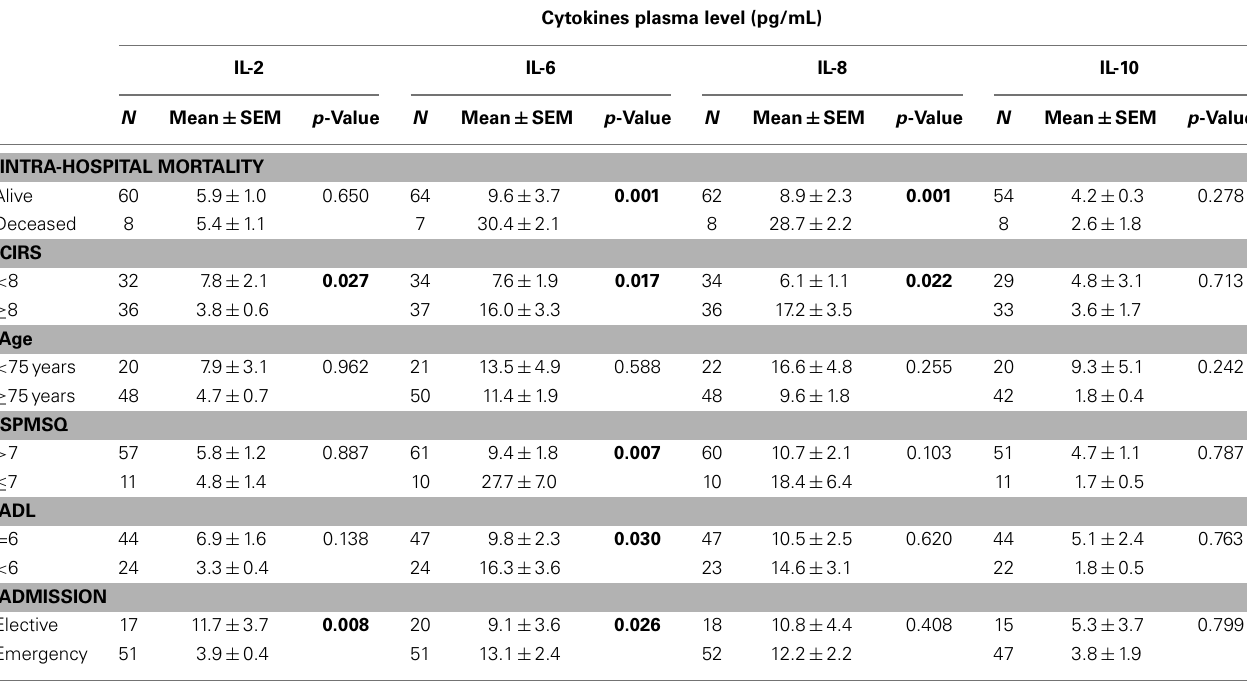
Table 3 | Correlation between cytokines plasma level and different features independently of POD onset